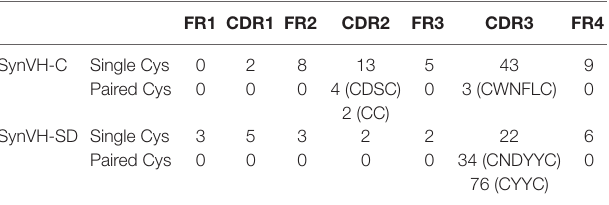
Table 5 | Non-canonical cysteine content is low in SynVH-C and SynVH-SD